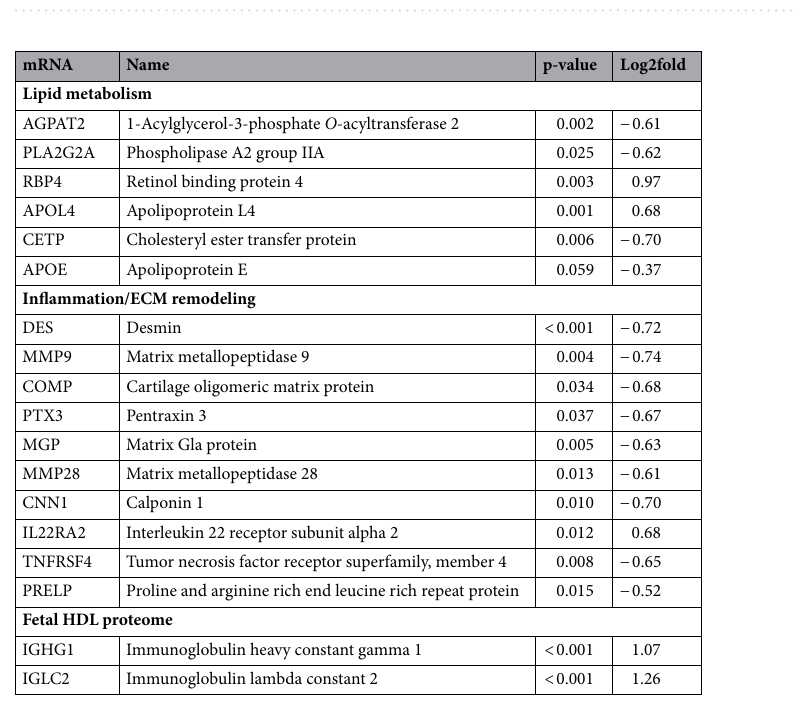
Table 2. Some of the mRNAs involved in lipid metabolism and inflammation/ECM remodeling from the RNAseq analysis showing downregulated and upregulated mRNAs in placenta of women with the highest HDL-C